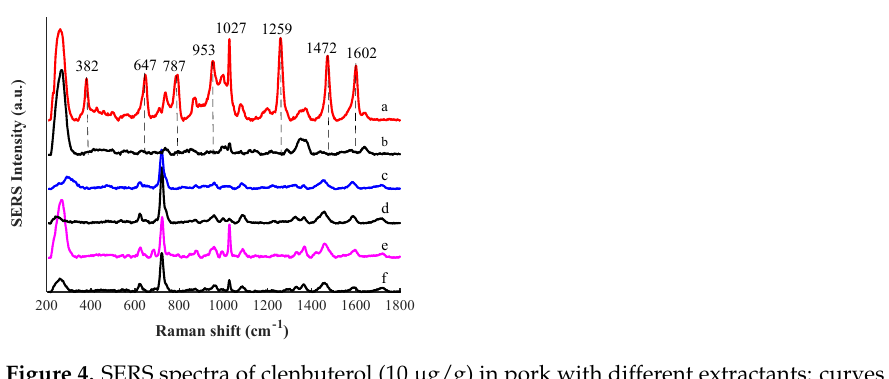
Figure 4. SERS spectra of clenbuterol (10 µ g/g) in pork with different extractants: curves a, c, and e represent the SERS spectra of clenbuterol in pork when ethyl acetate, acetonitrile, and methanol were used as extraction agents, respectively; curves b, d, and f represent the control group of SERS spectra of pork when ethyl acetate, acetonitrile, and methanol were used as extraction agents, respectively.